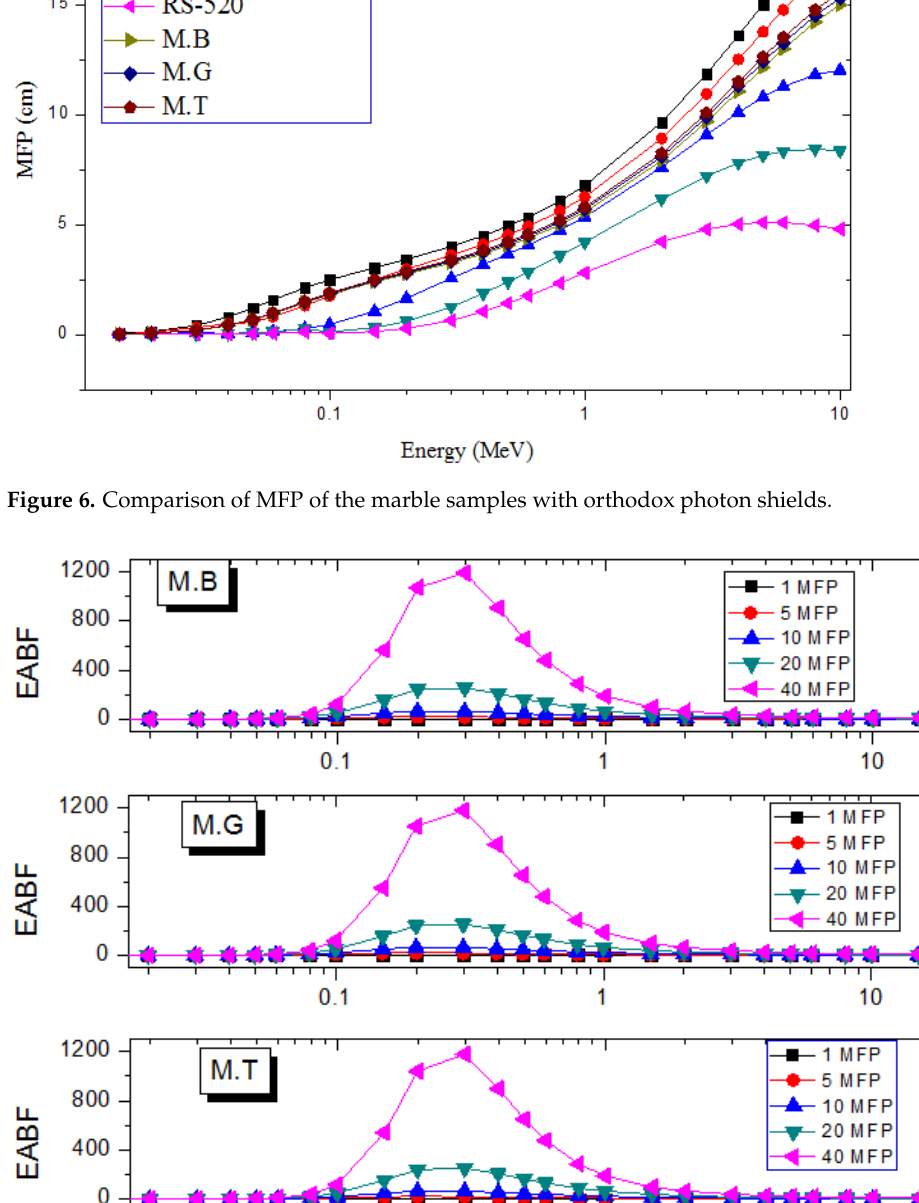
Figure 8. Variation of EBF of the marble samples with energy at selected depths.